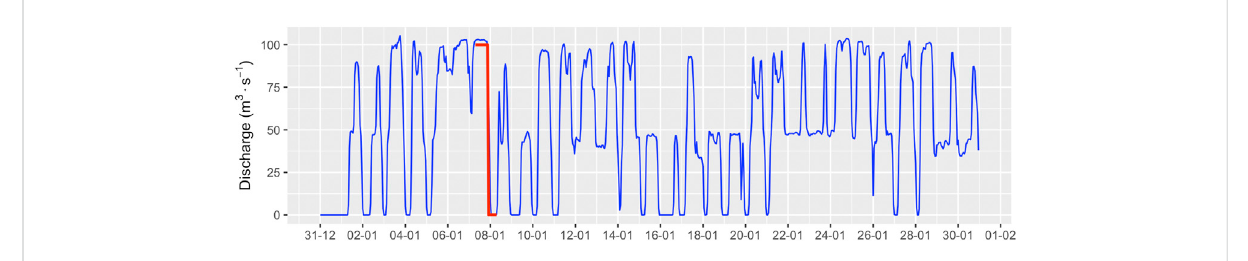
FIGURE 5 ObservedproductionfromoneortwoturbinesintheBratsberg power plantfrom01/01/2010to 01/02/2010.The standardhydrographusedin the dewatering analysis is shown in red. An environmental fl ow of 30 m 3 s − 1 comes in addition to the release from the power plant.